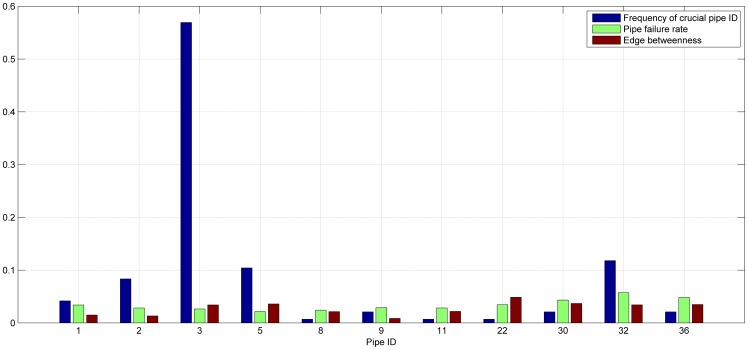
Frequency diagram of crucial pipes.